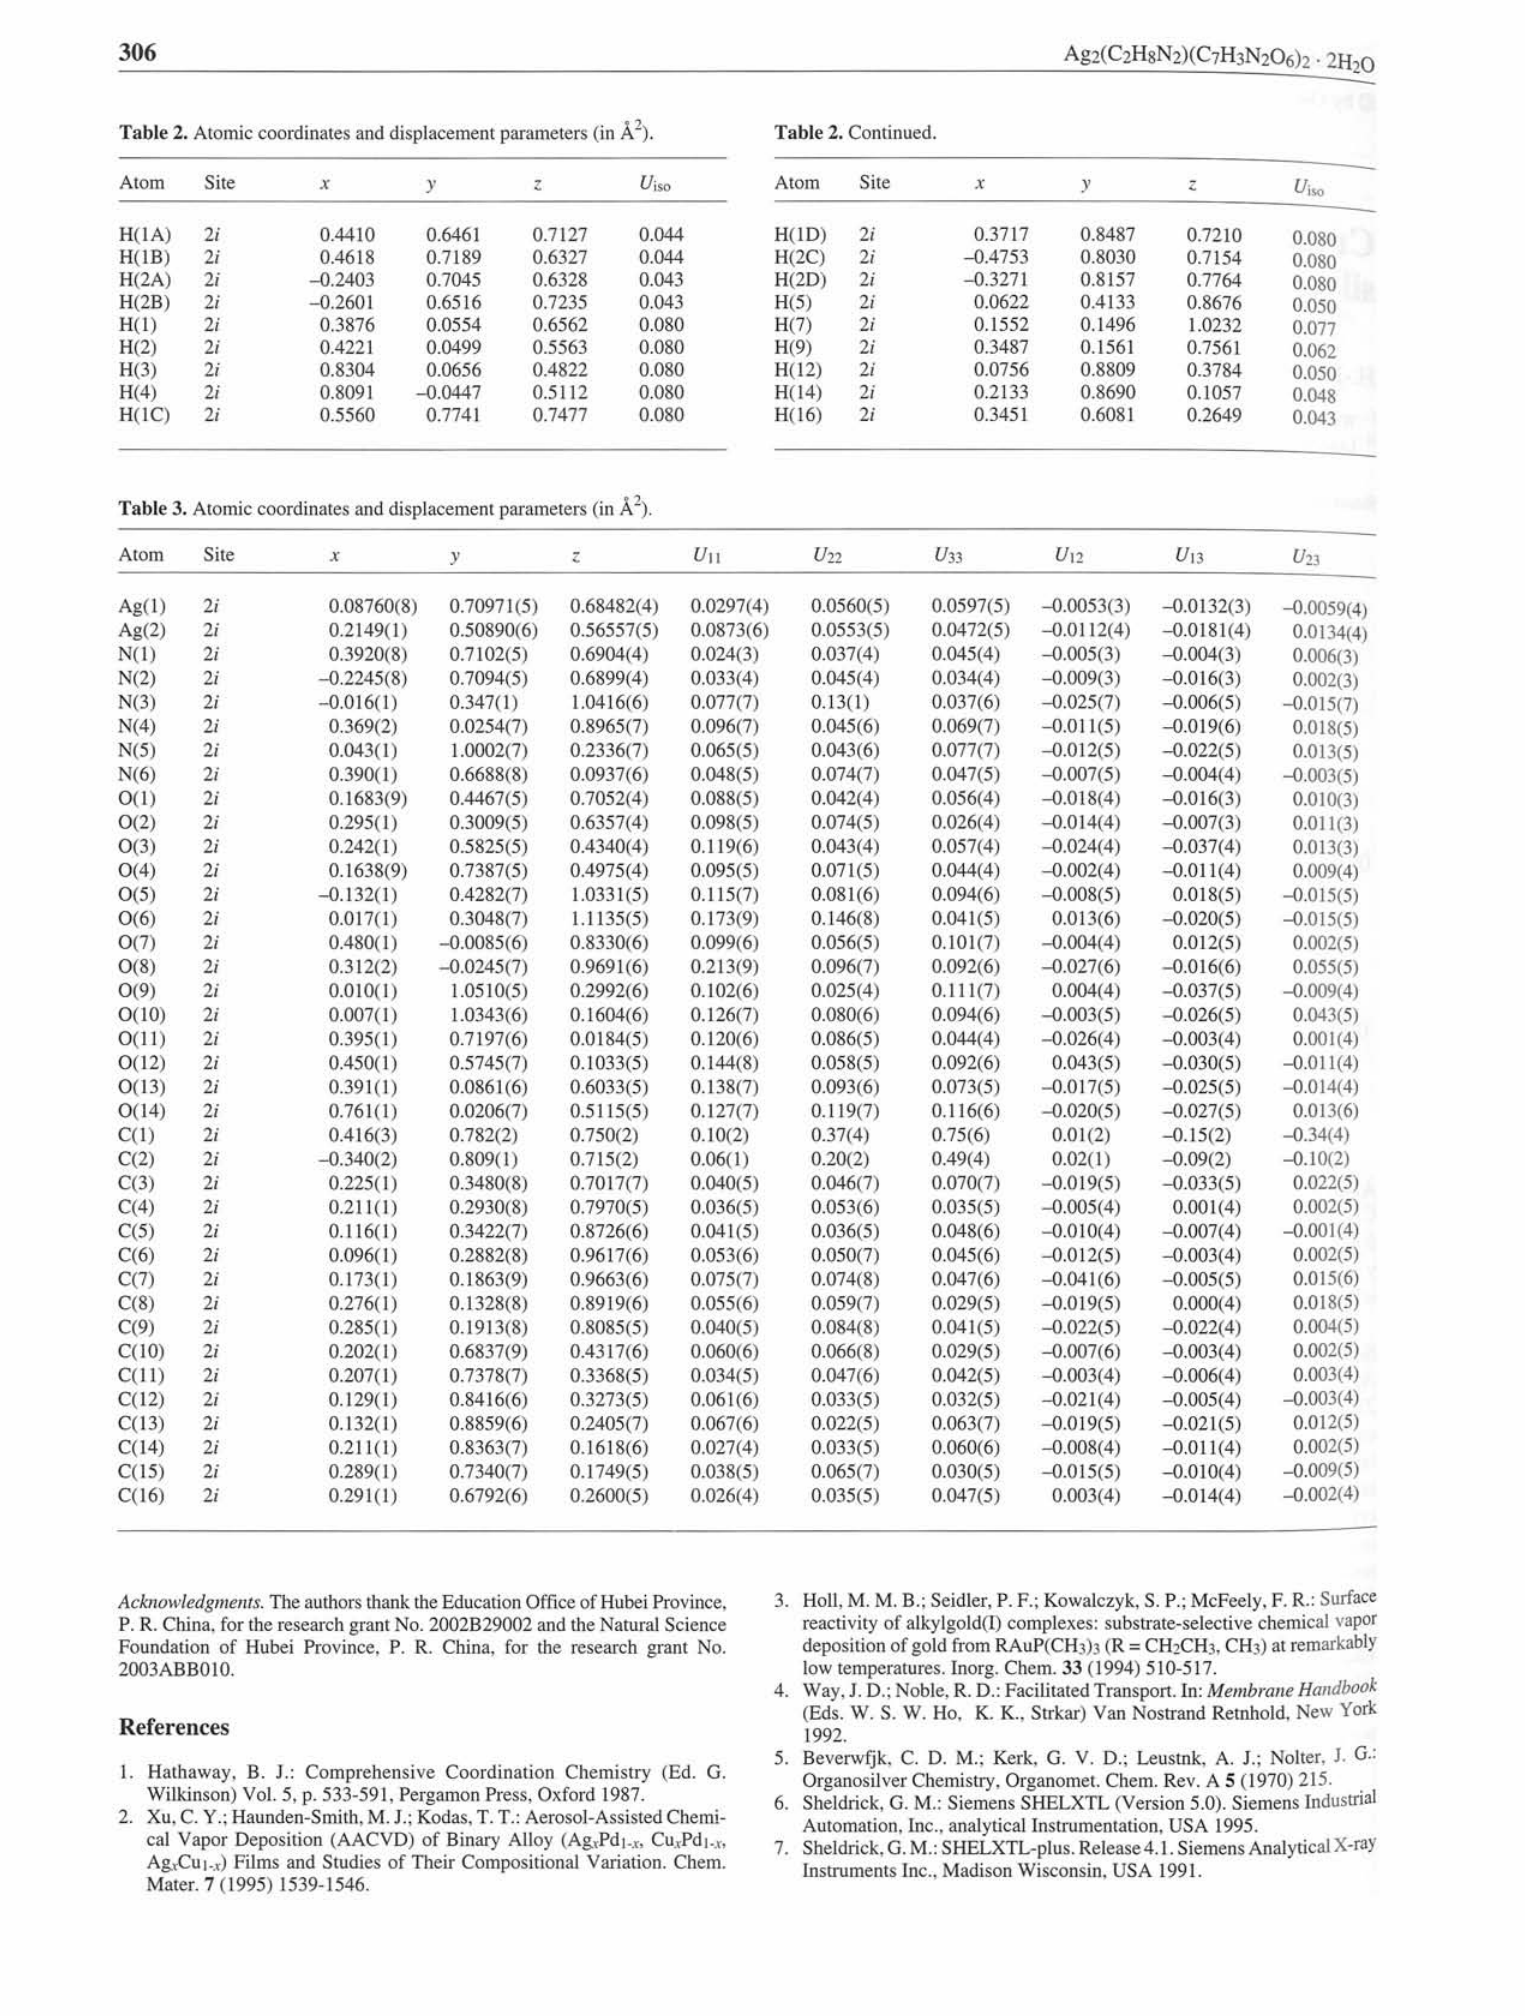
Table 2. Atomic coordinates and displacement parameters (in Â 2 ). Table 2. Continued.